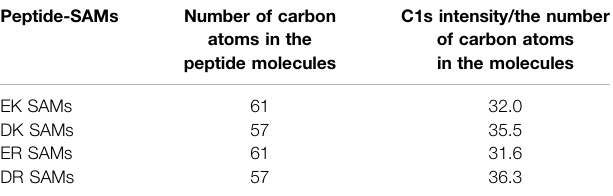
TABLE 2 | The number of carbon atoms in the peptide molecules and relative packing density with respect to peptides. The packing densities were calculated by C1s intensity and divided by the number of carbon atoms in the molecules.